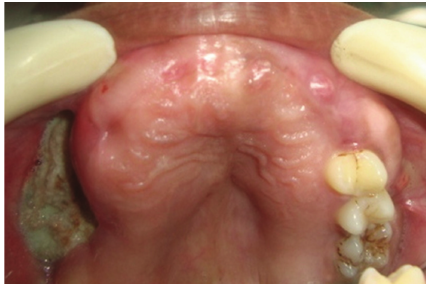
Figure 10: Intraoral photograph of patient’s mother (Case 2).